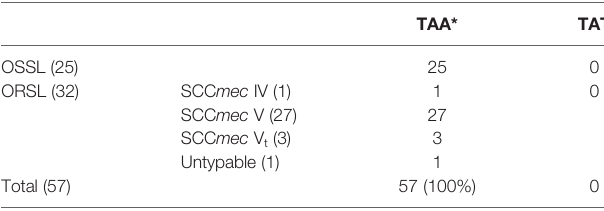
TABLE 3 | Nucleotide sequences of the 18 th codon in the 3 rd repeat of various isolates with nine repeats in the R region of vWbl .